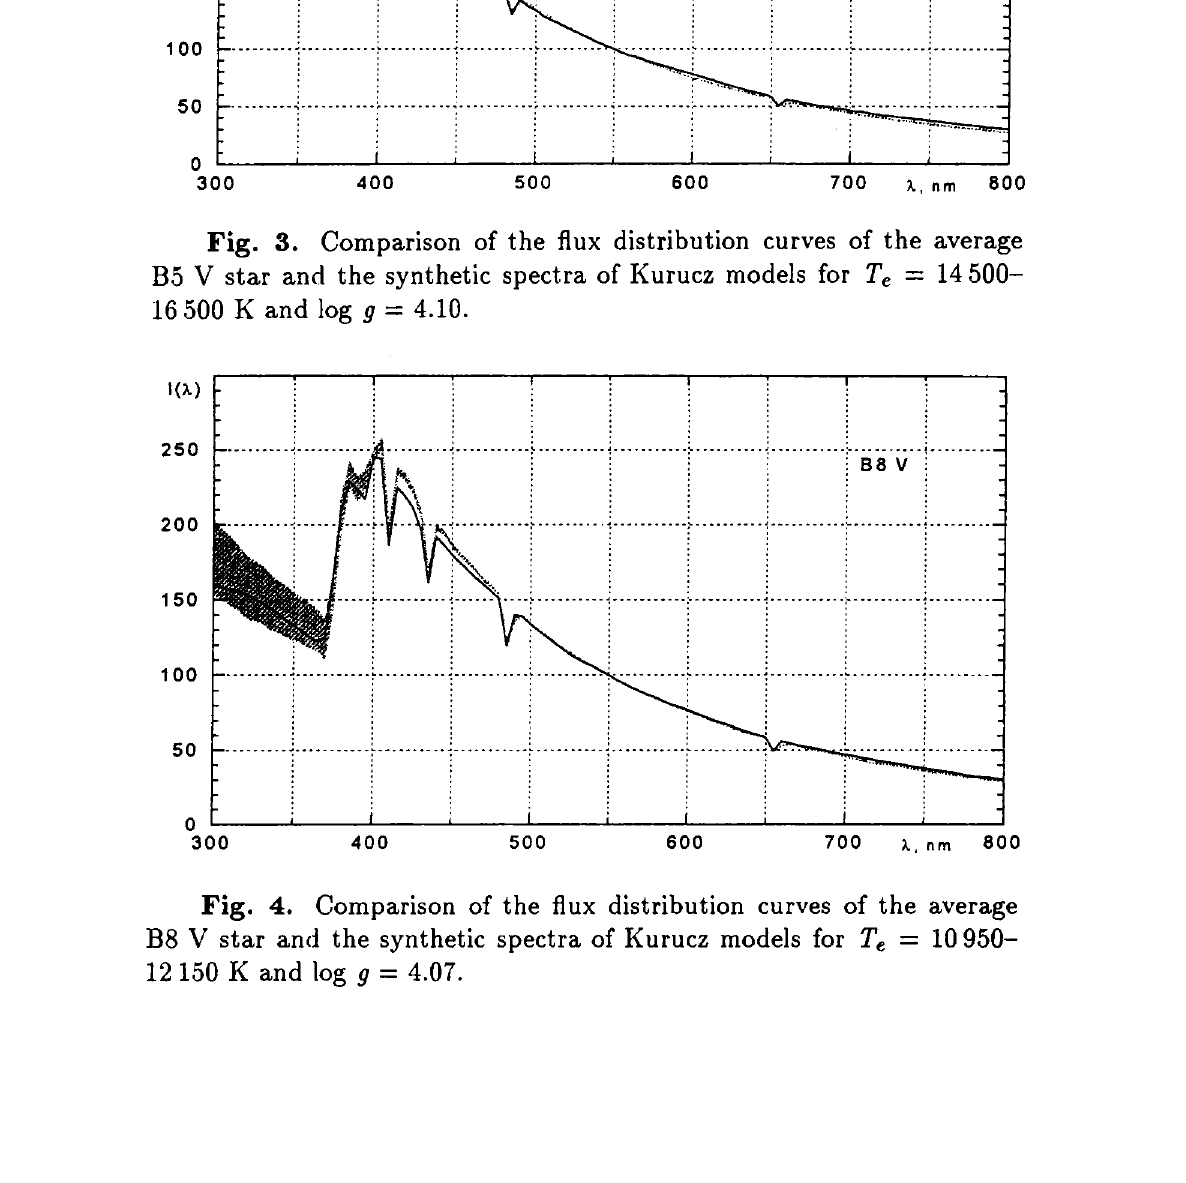
Fig. 4. Comparison of the flux distribution curves of the average B8 V star and the synthetic spectra of Kurucz models for T 12 150 K and log g =